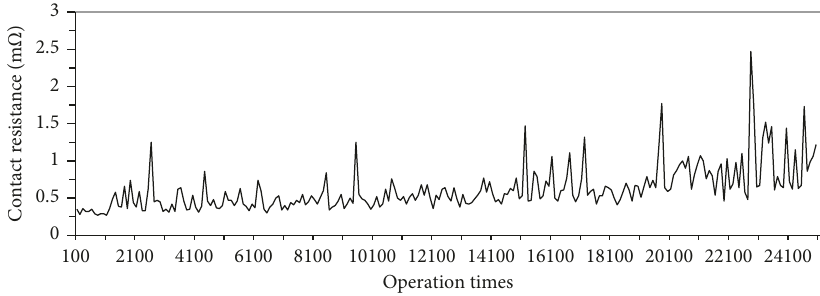
Figure 4: The contact resistance of Ag-SnO 2 /La 2 O 3 contact material with 50nm doped particle size.